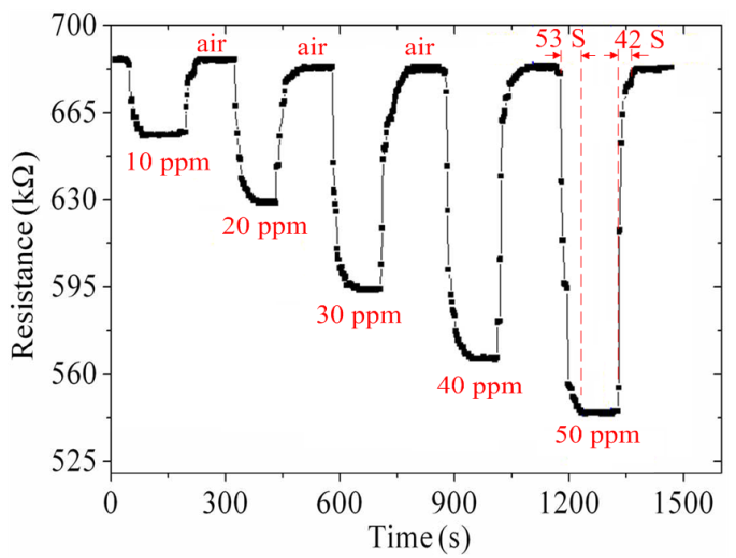
Figure 11. Test of the ammonia sensor.